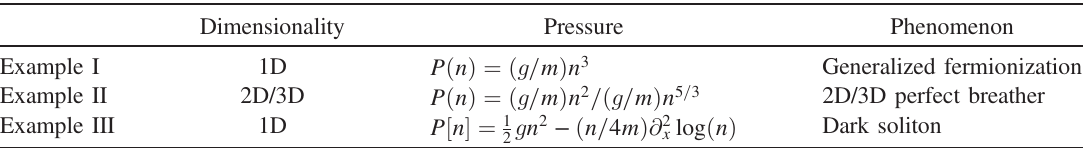
TABLE I. Summary of examples of physical realizations of the ideal-gas approach to hydrodynamics discussed in this paper. As illustrated by the table, these examples include different systems in different dimensions, and the diverse phenomena in these interacting systems can all be obtained by solutions of the Liouville equation. In the pressure column, P ½ n (cid:2) denotes how the pressure depends on the density n , and g is the interaction parameter for different